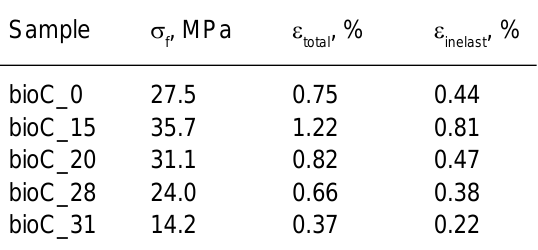
Table 2. Strength, complete and inelastic strain before destruction of the non-activated and activated biocarbons.